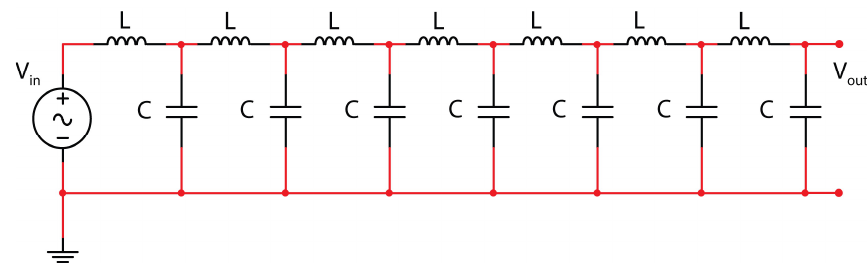
Figure 3. Ladder network of seven L–C cells.